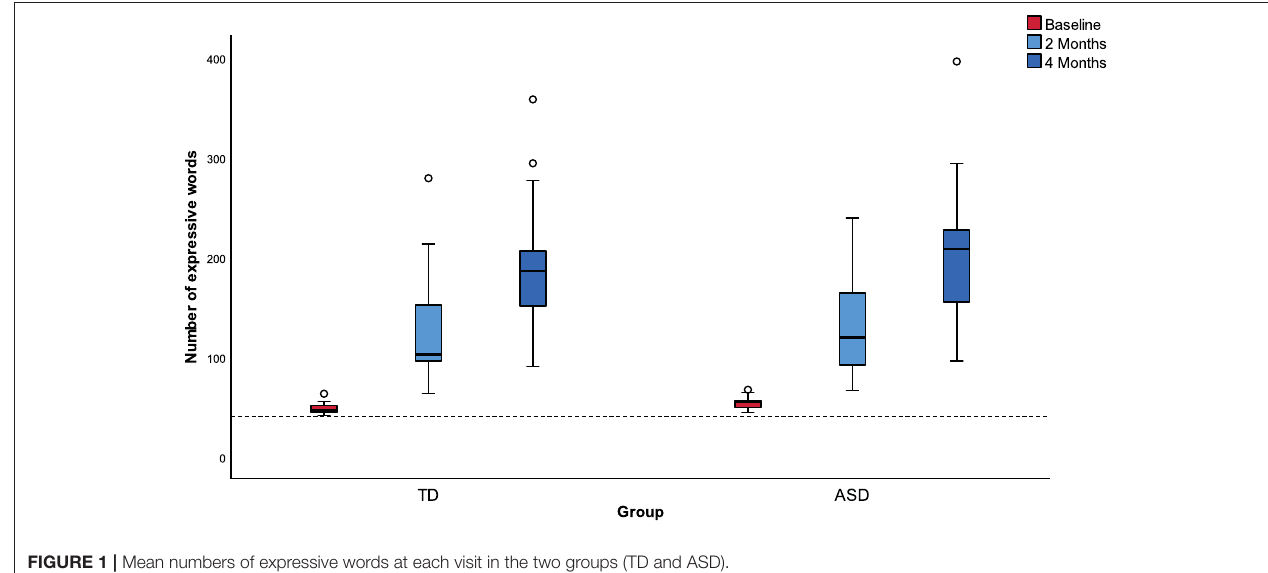
FIGURE 1 | Mean numbers of expressive words at each visit in the two groups (TD and ASD).